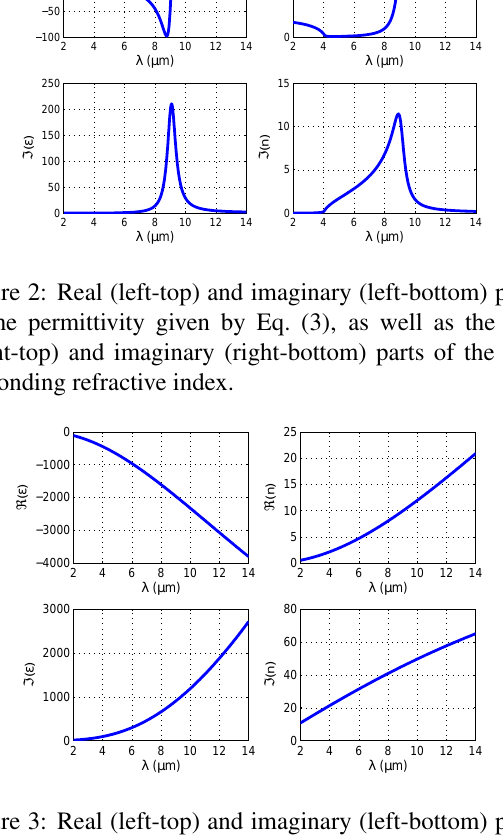
Figure 3: Real (left-top) and imaginary (left-bottom) parts of the permittivity of copper given from Palik [24], as well as the real (right-top) and imaginary (right-bottom) parts of the corresponding refractive